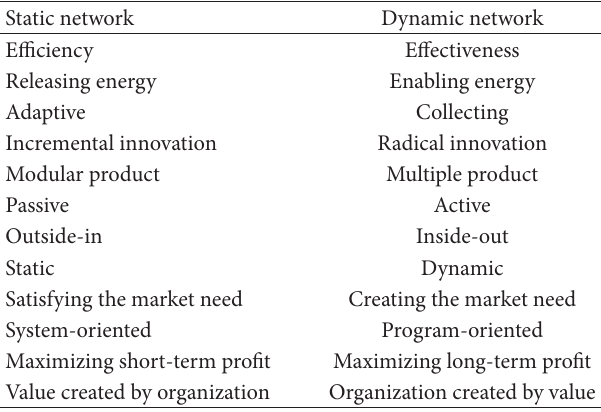
Table 1: The characteristics of static and dynamic collaborating